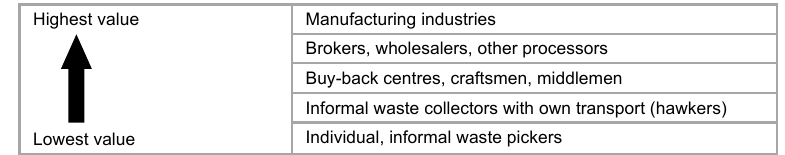
Hierarchy of role players in the recycling